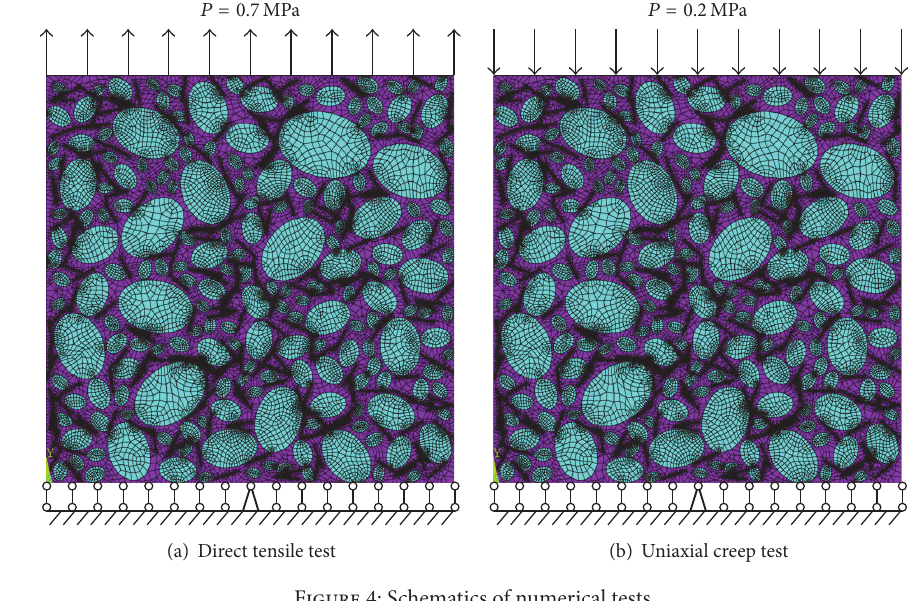
Figure 4: Schematics of numerical tests. Table 2: Properties of asphalt.